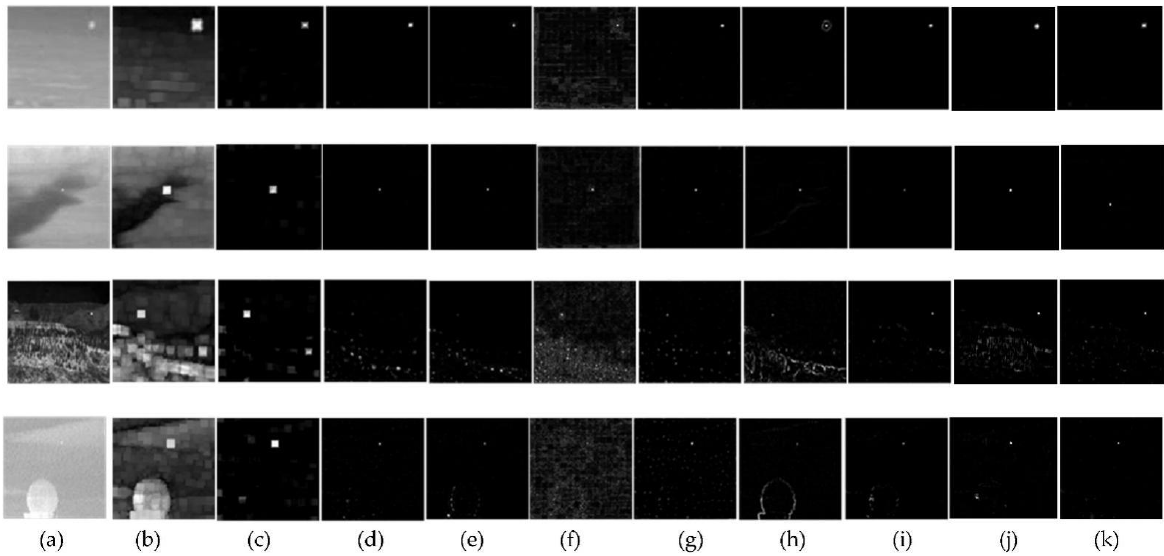
Figure 5. Qualitative comparative results under different scenes: ( a ) Original images; ( b – k ) processing result of LCM, RLCM, MPCM, HBMLCM, AMWLCM, TLLCM, LR, AAGD, LEF and RBLM-REC (proposed algorithm).